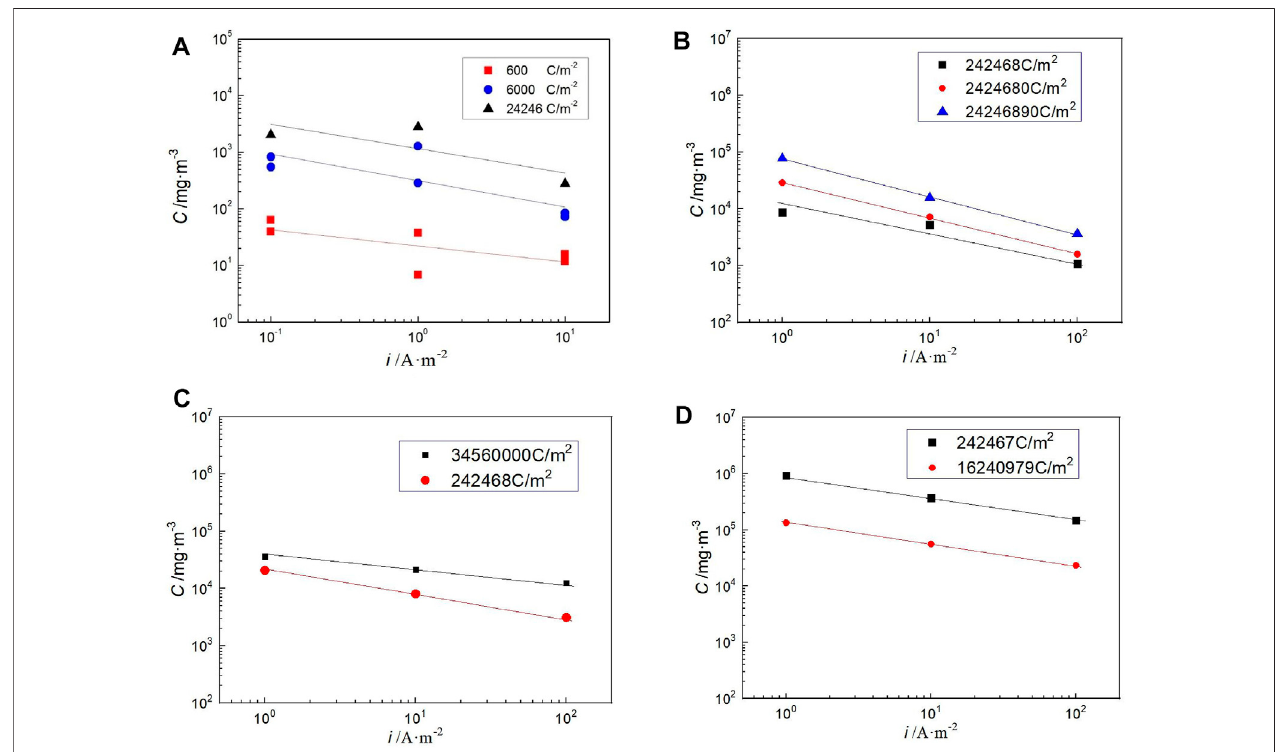
FIGURE9| Variation inhydrogen concentrationinQ235steelwithcharging currentdensity forsame fi xedtotalchargeat differenttemperaturesinsaturatedhighly compacted bentonite.